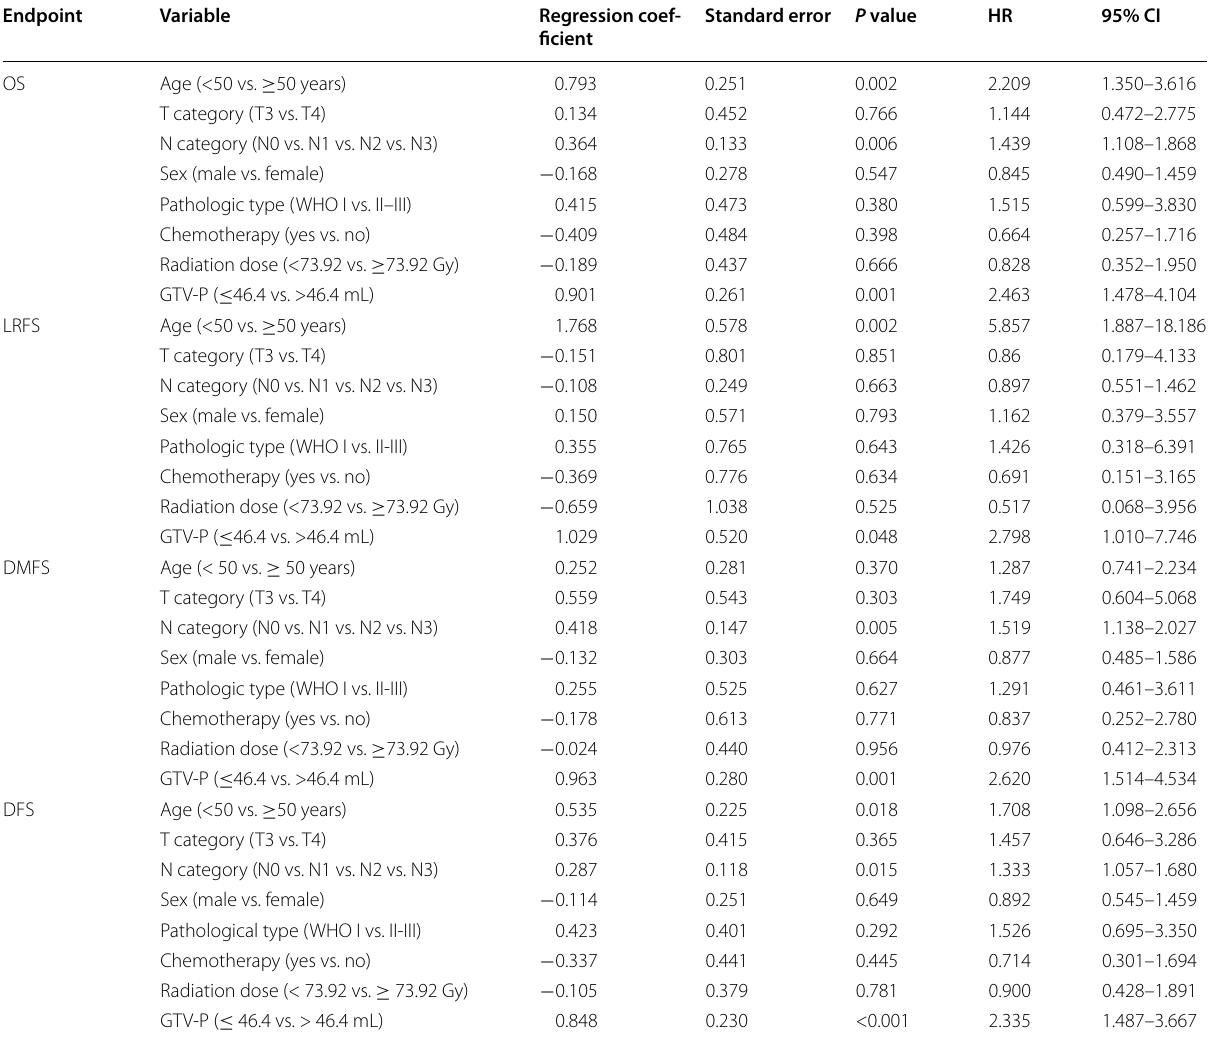
Table 4 Multivariate analysis of prognostic factors for locally advanced